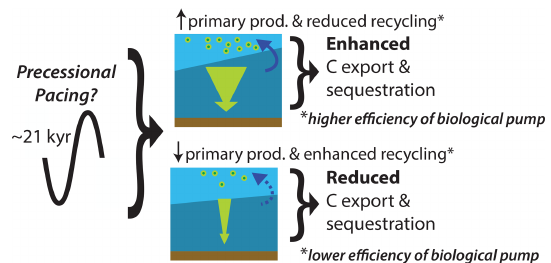
Figure 7. Cycles of enhanced and reduced carbon (C) export and sequestration result from precessional paced variations in primary productivity and recycling in surface waters (i.e., changes in the ef- ficiency of the biological pump). A shallower thermocline (steeper boundary between light- and dark-blue waters) would result in in- creased primary production and reduced recycling in the surface waters due to changes in water column stratification, continental nutrient fluxes, and upwelling intensity which increases nutrients (solid blue arrow) and enhances C export out of the surface waters (wide green arrow). A deeper thermocline (near horizontal bound- ary between light- and dark-blue waters) would result in reduced primary production and enhanced recycling in the surface waters due to reduced nutrient availability (dashed blue arrow) and reduces C export out of the surface waters (thin green arrow). This ENSO- like variability could have controlled carbon export in the Maas-